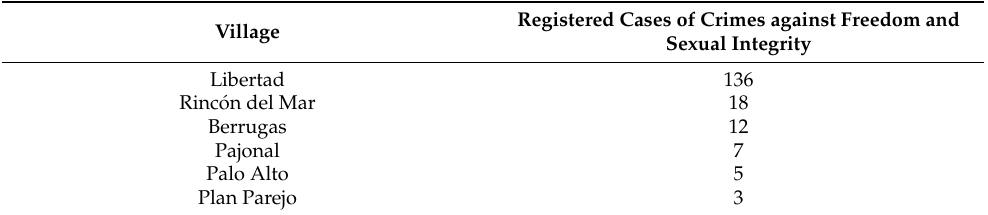
Table 4. Registered cases of crimes against freedom and sexual integrity in the villages of the municipality of San